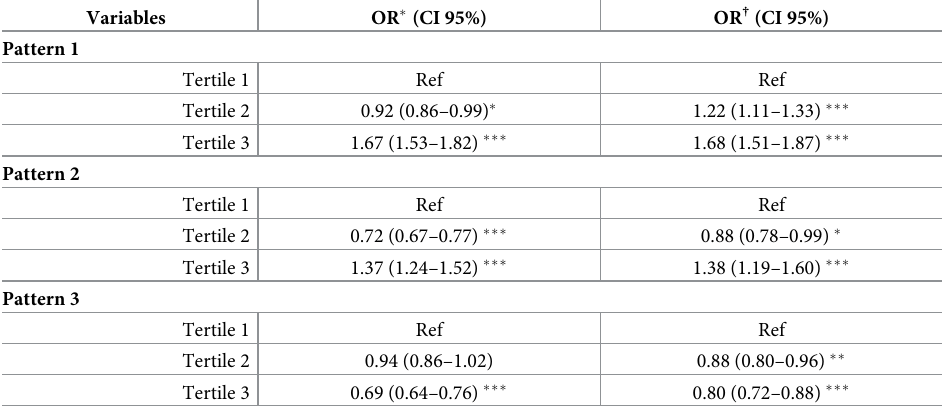
Table 3. Crude and adjusted logistic regression models (95% CIs) for common mental disorders in Brazilian ado- lescents. Study of Cardiovascular Risks in Adolescents (ERICA), Brazil, 2013–2014.